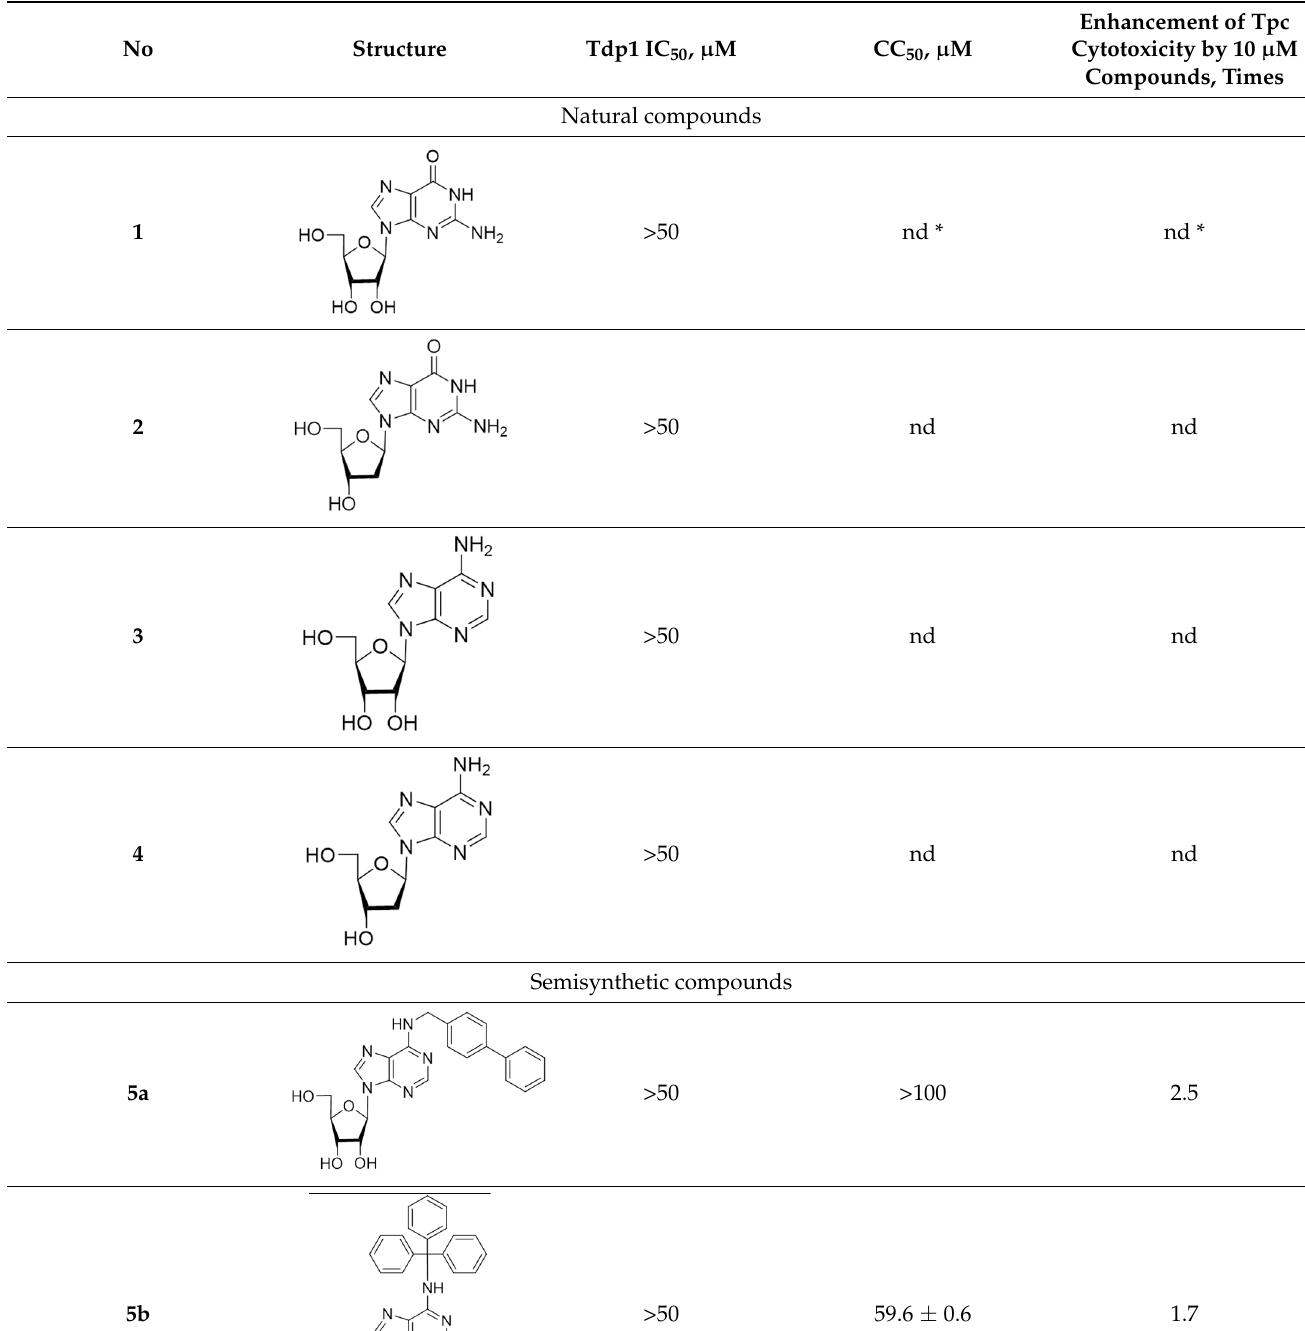
Table 1. Inhibitory activities of compounds against Tdp1 and their cytotoxicity against HeLa cells. The half maximal inhibitory concentration (IC50) is a measure of the potency of a substance in inhibiting. IC50 is a quantitative measure that indicates how much of an inhibitor is needed to inhibit enzymatic activity by 50%. Moreover, 50% cytotoxicity concentration (CC50) is the concentration of test compounds required to reduce cell viability by 50%.